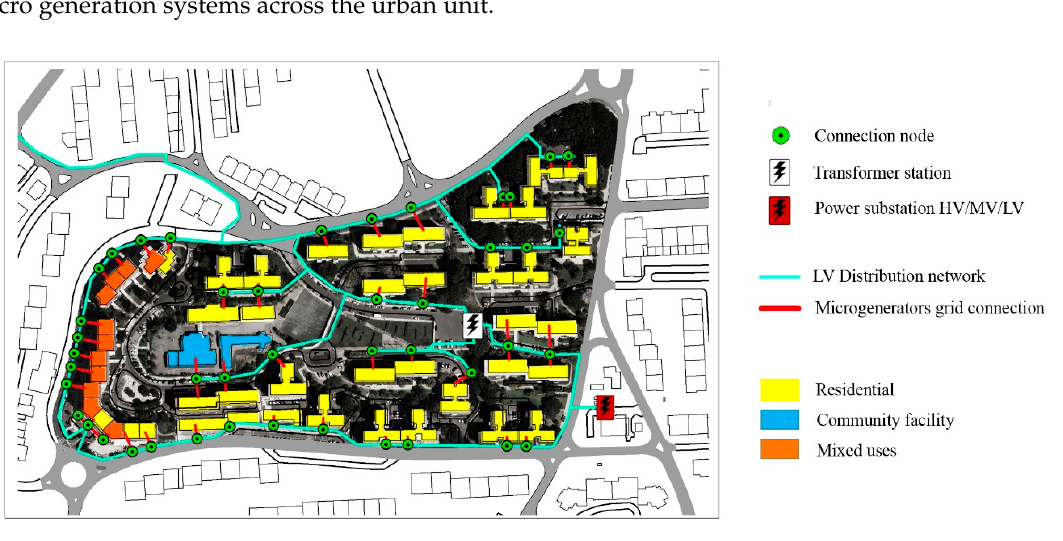
Figure 3. Layout of the ‘Produces and Sells’ scenario.